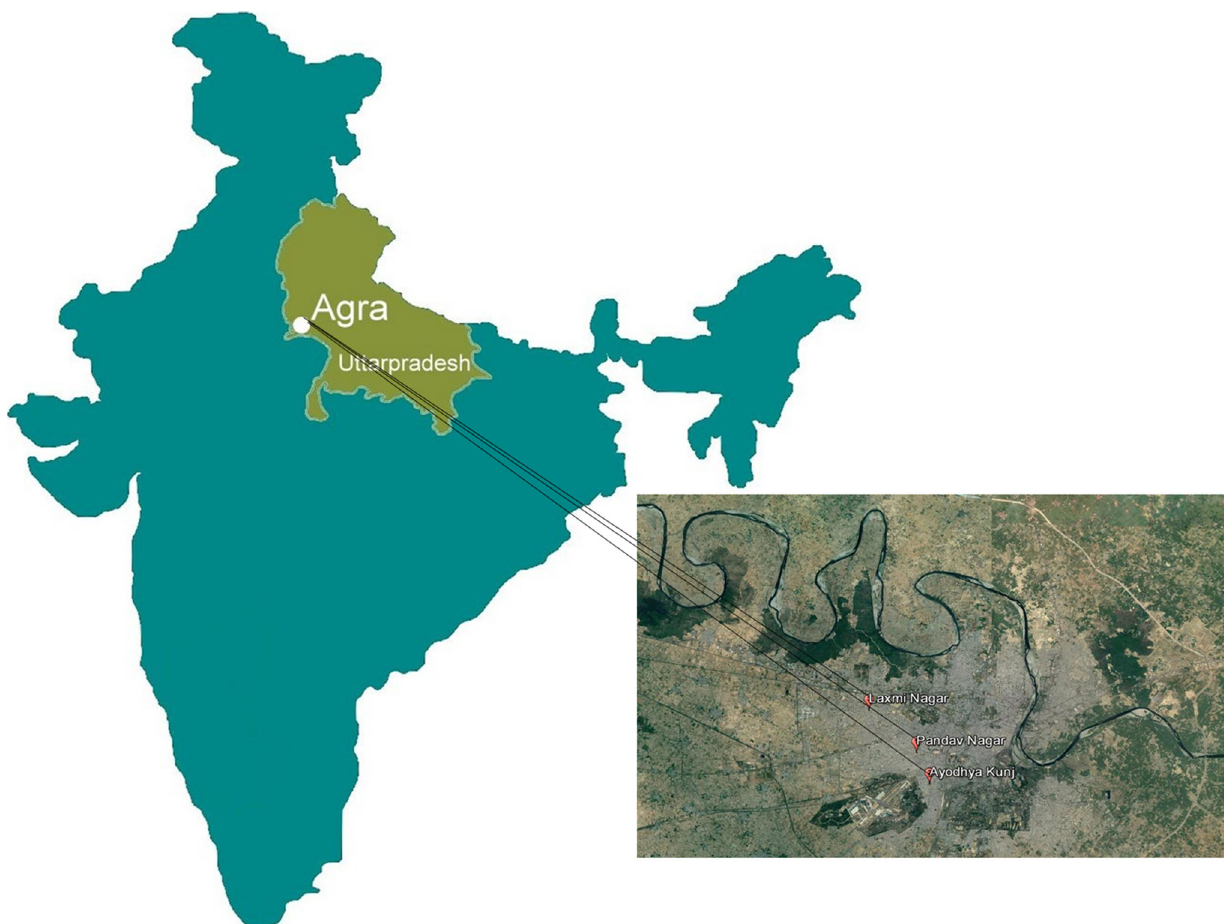
Fig. 1 Schematic map (not to scale) of India with study area (Agra city, Uttar Pradesh,